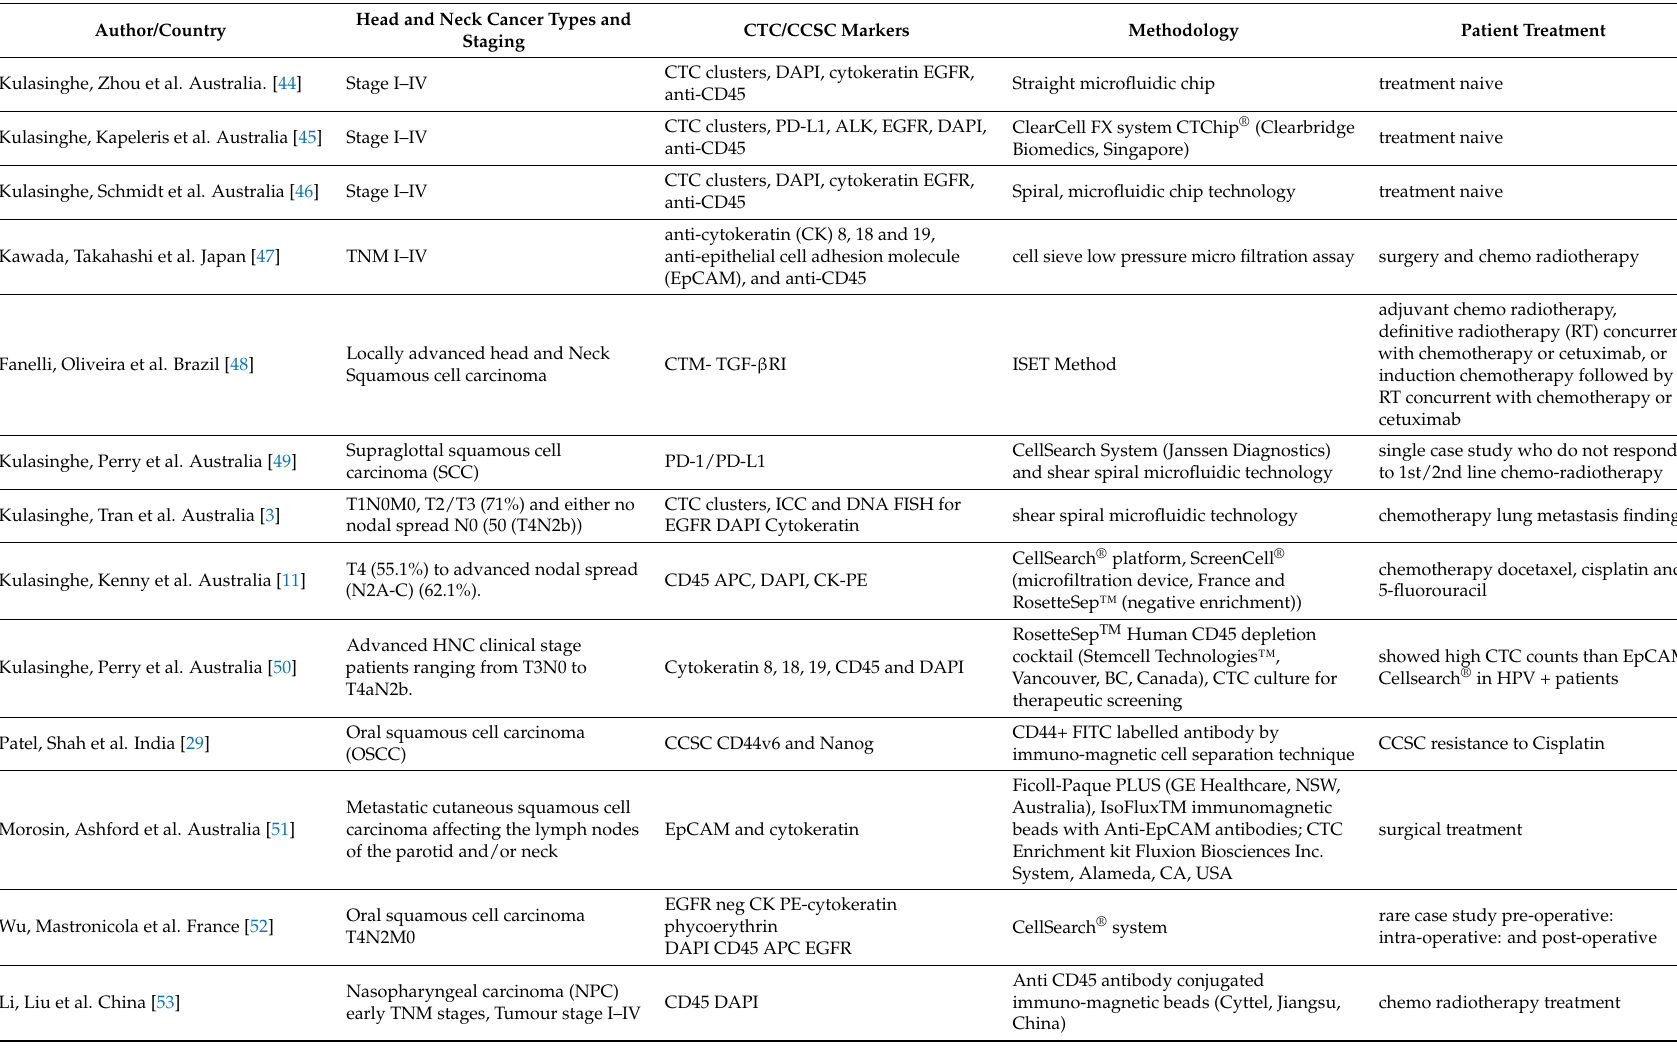
Table 1. Overview of head and neck circulating tumour cells